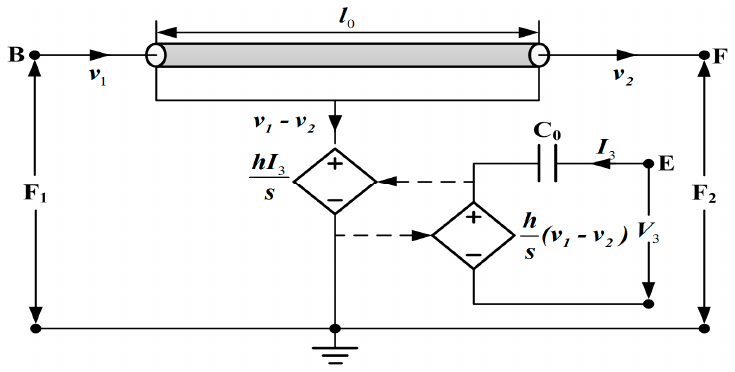
Figure 4. Leach’s equivalent circuit model for a thickness vibration piezoelectric ring.